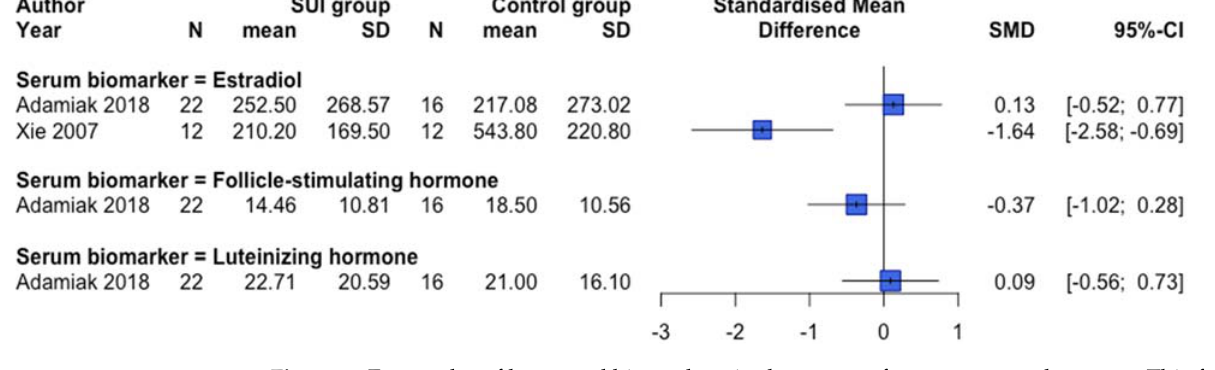
Figure 7. Forest plot of hormonal biomarkers in the serum of premenopausal women. This forest plot shows differences in hormonal biomarkers in the serum between premenopausal patients with SUI and controls, subdivided per hormone. Abbreviations: CI confidence interval, N number, SD standard deviation, SMD standardized mean difference, SUI stress urinary incontinence.